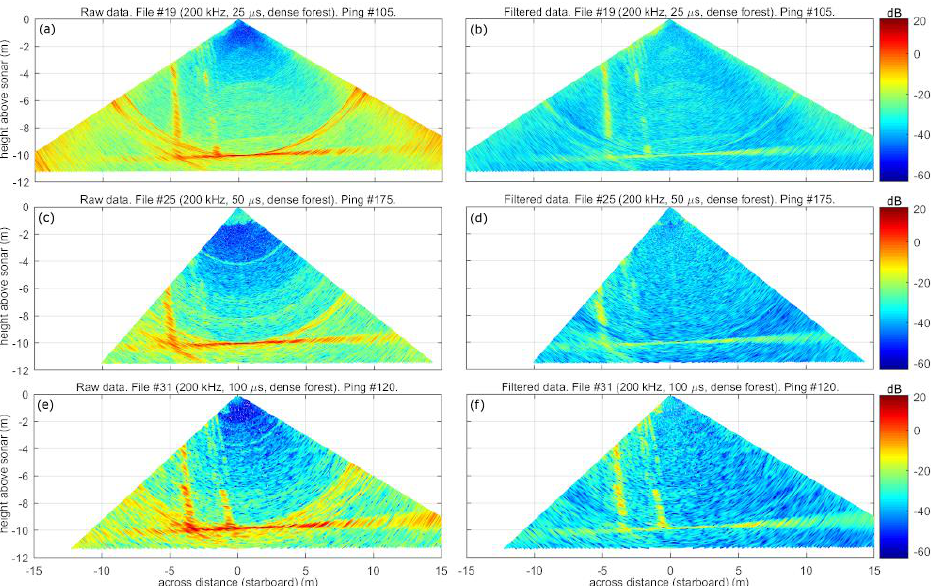
Figure 5. Illustration of EM 2040 C MBES water-column data acquired at 200 kHz over the dense forest patch before and after application of the SRSN filter, for different pulse length settings: ( a ) 25 μs pulse data example before filtering and ( b ) same ping after filtering, ( c ) 50 μs pulse data example before filtering and ( d ) same ping after filtering, ( e ) 100 μs pulse data example before filtering and ( f ) same ping after filtering. Data shown are for the ping corresponding to the shortest horizontal distance to the patch, in the first file acquired for each setting.